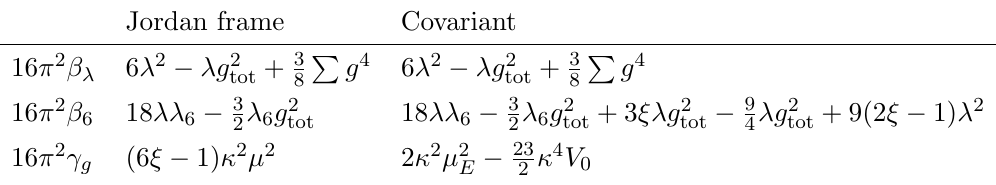
Table 4 . W and Z vector boson contributions to the (cid:12) (cid:0) functions for the quartic scalar self-coupling (cid:21) and the sixth order scalar self-coupling (cid:21) 6 of a gravity coupled scalar (cid:12)eld at at leading order in (cid:20) 4 V 0 . The metric wave function anomalous dimension is given to order (cid:20) 4 V 0 . The covariant result uses a geodesic expansion on (cid:12)eld space and is independent of the frame